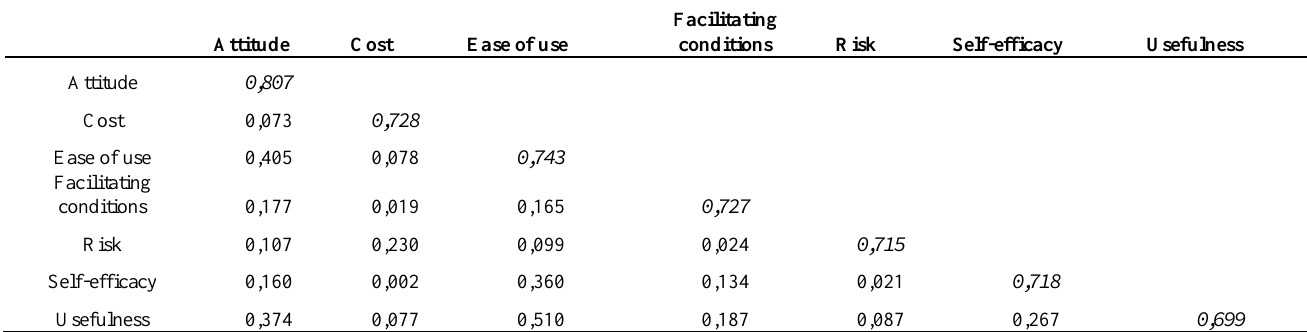
Table 4: Squared correlations between constructs in the female measurement model